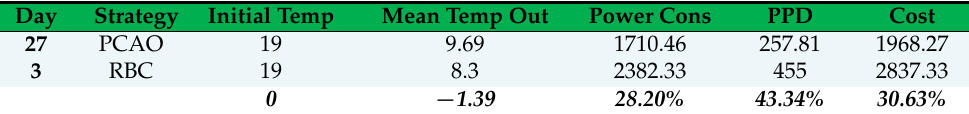
Table 14. Comparison between the PCAO (27th) and RBC (3rd) winter